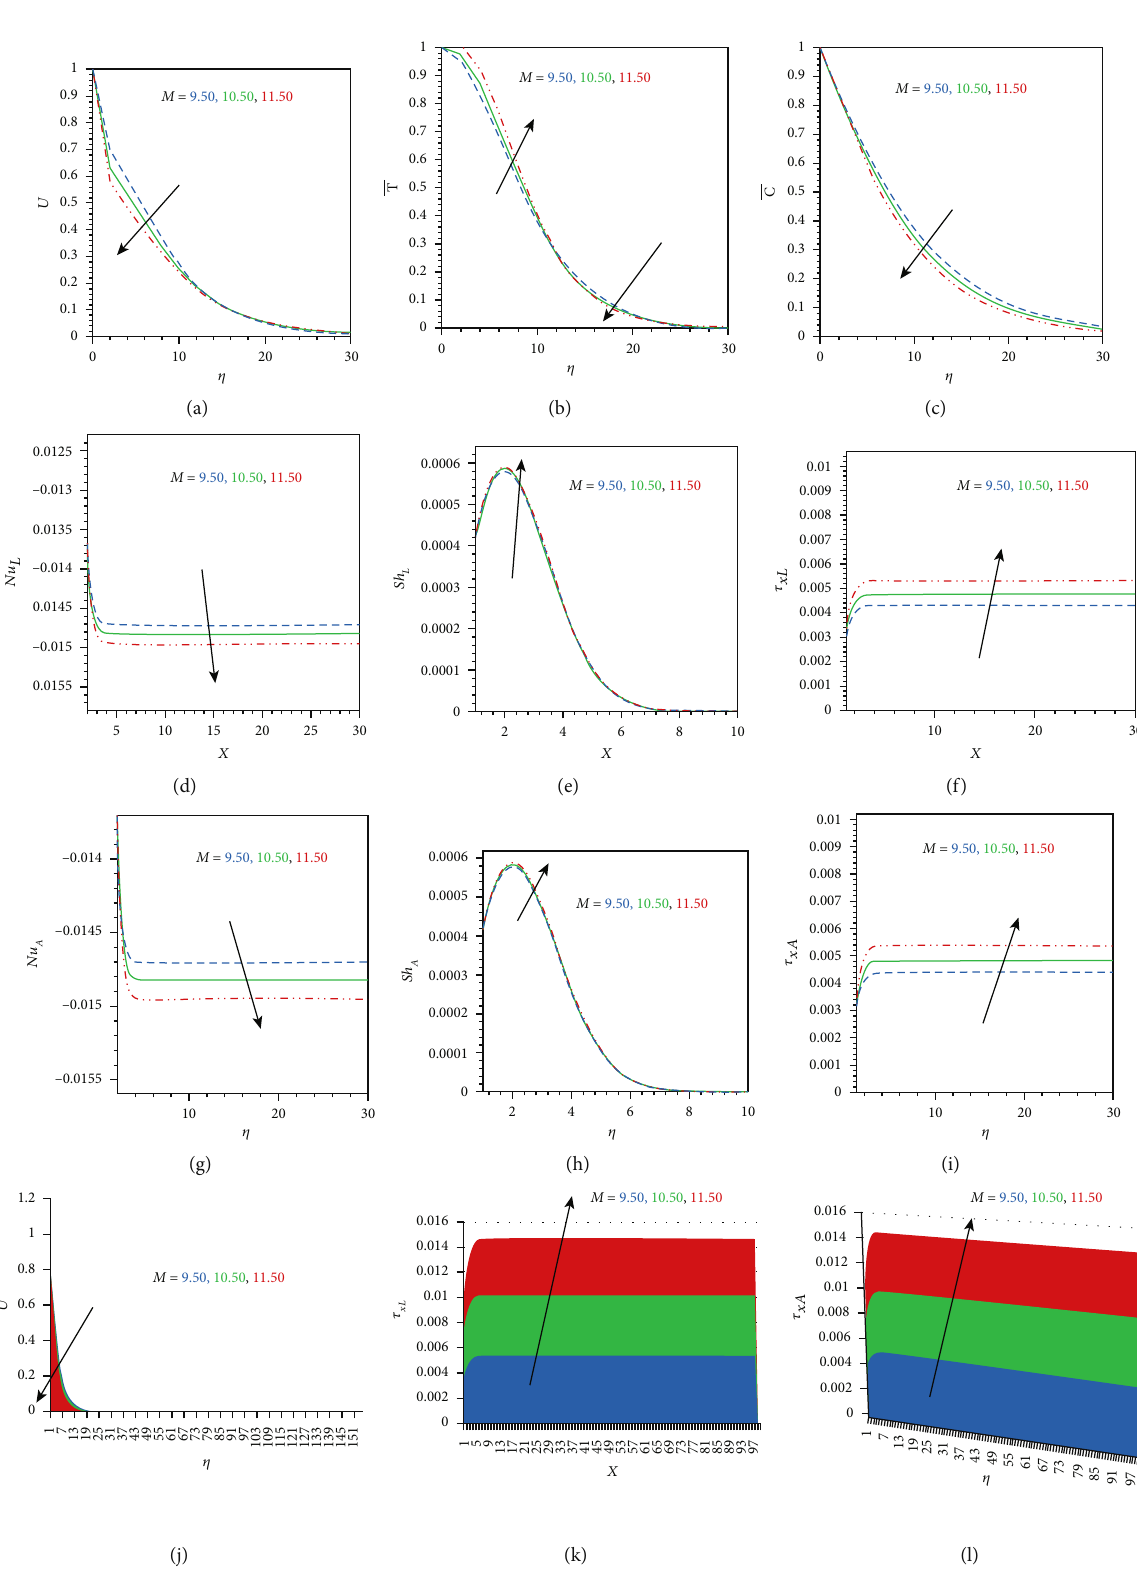
, (e) Sh , (f) τ , (g) Nu , (h) Sh (i) τ , (j) fl ow L L A A xL xA